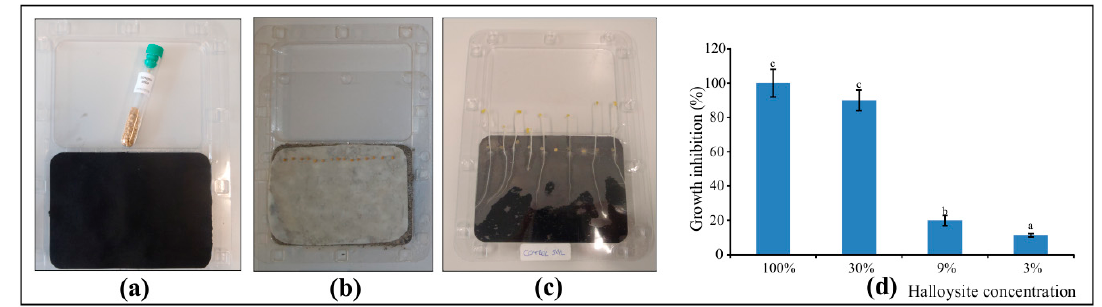
Figure 5. Experiment setup: Sinapsis alba L. seeds ( a ), germination ( b ), growth after three days ( c ), the growth inhibition results ( d ). Error bars represent ± standard error (n = 3). Bars marked with different letters differ significantly ( p < 0.05) according to Duncan’s test.